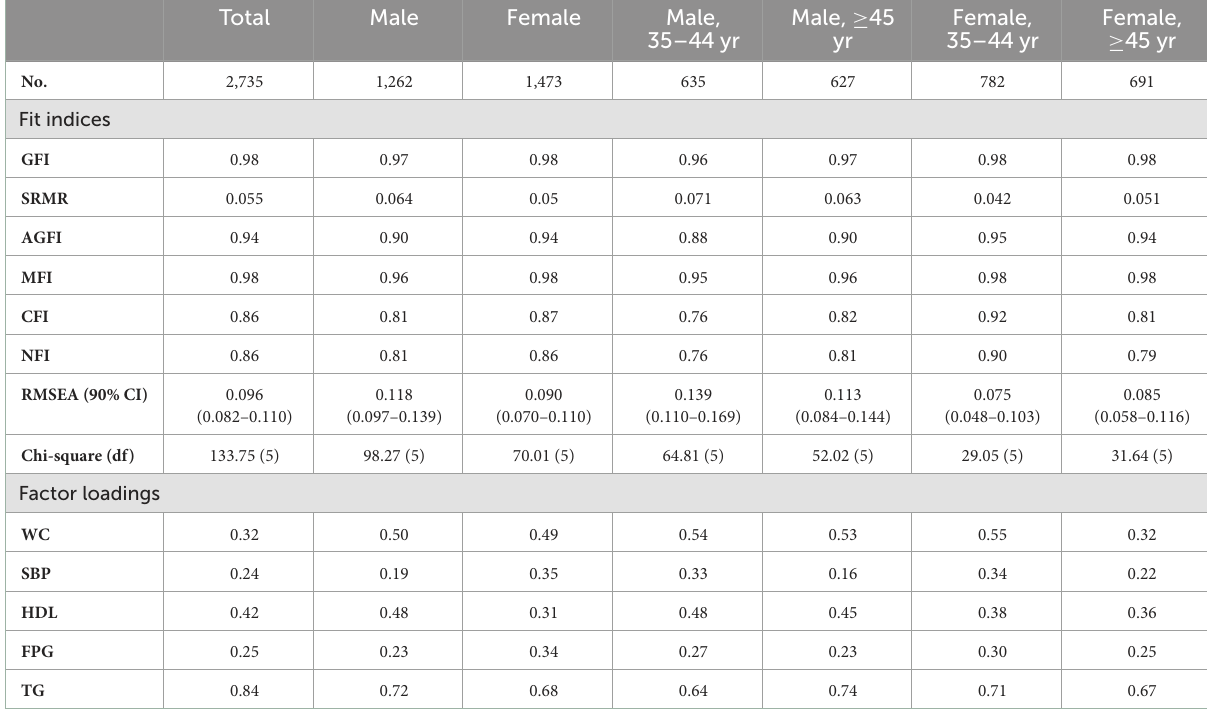
TABLE 1 Confirmatory factor analysis.